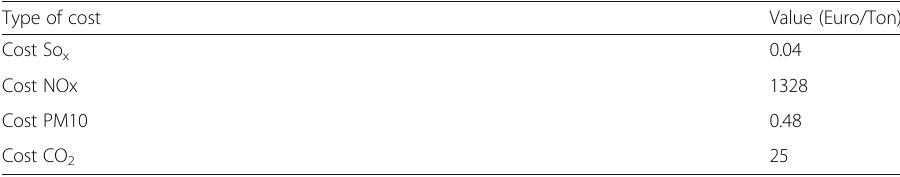
Table 9 External costs of pollutants Type of